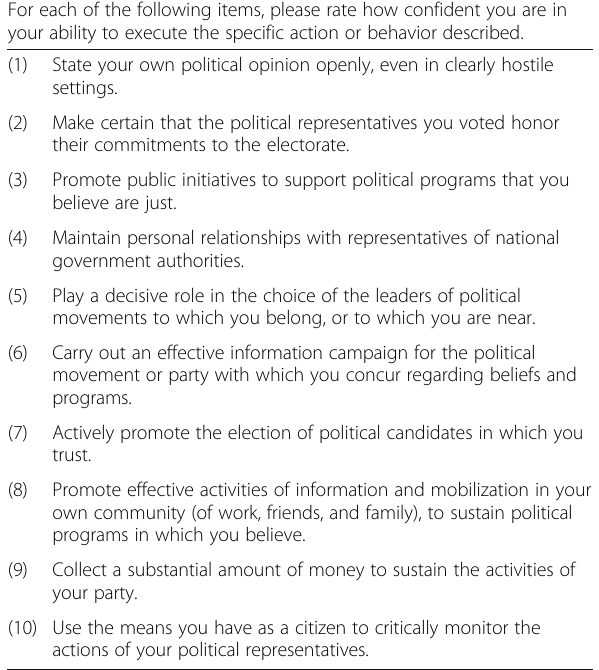
Table 1 Item wordings of the original P-PSE